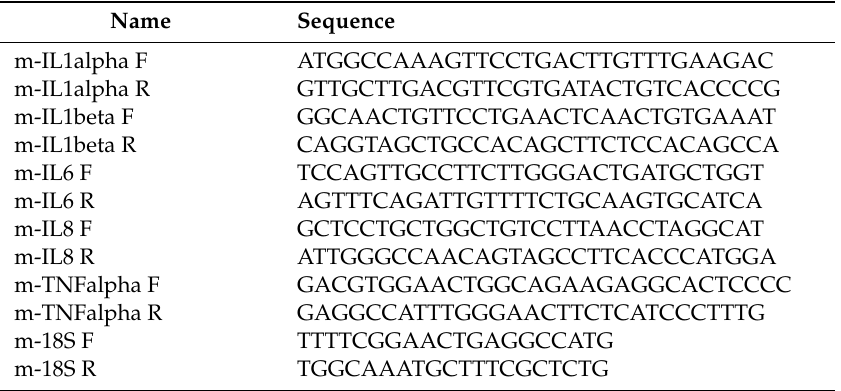
Table 1. Sequences of oligonucleotides used for mRNAs expression